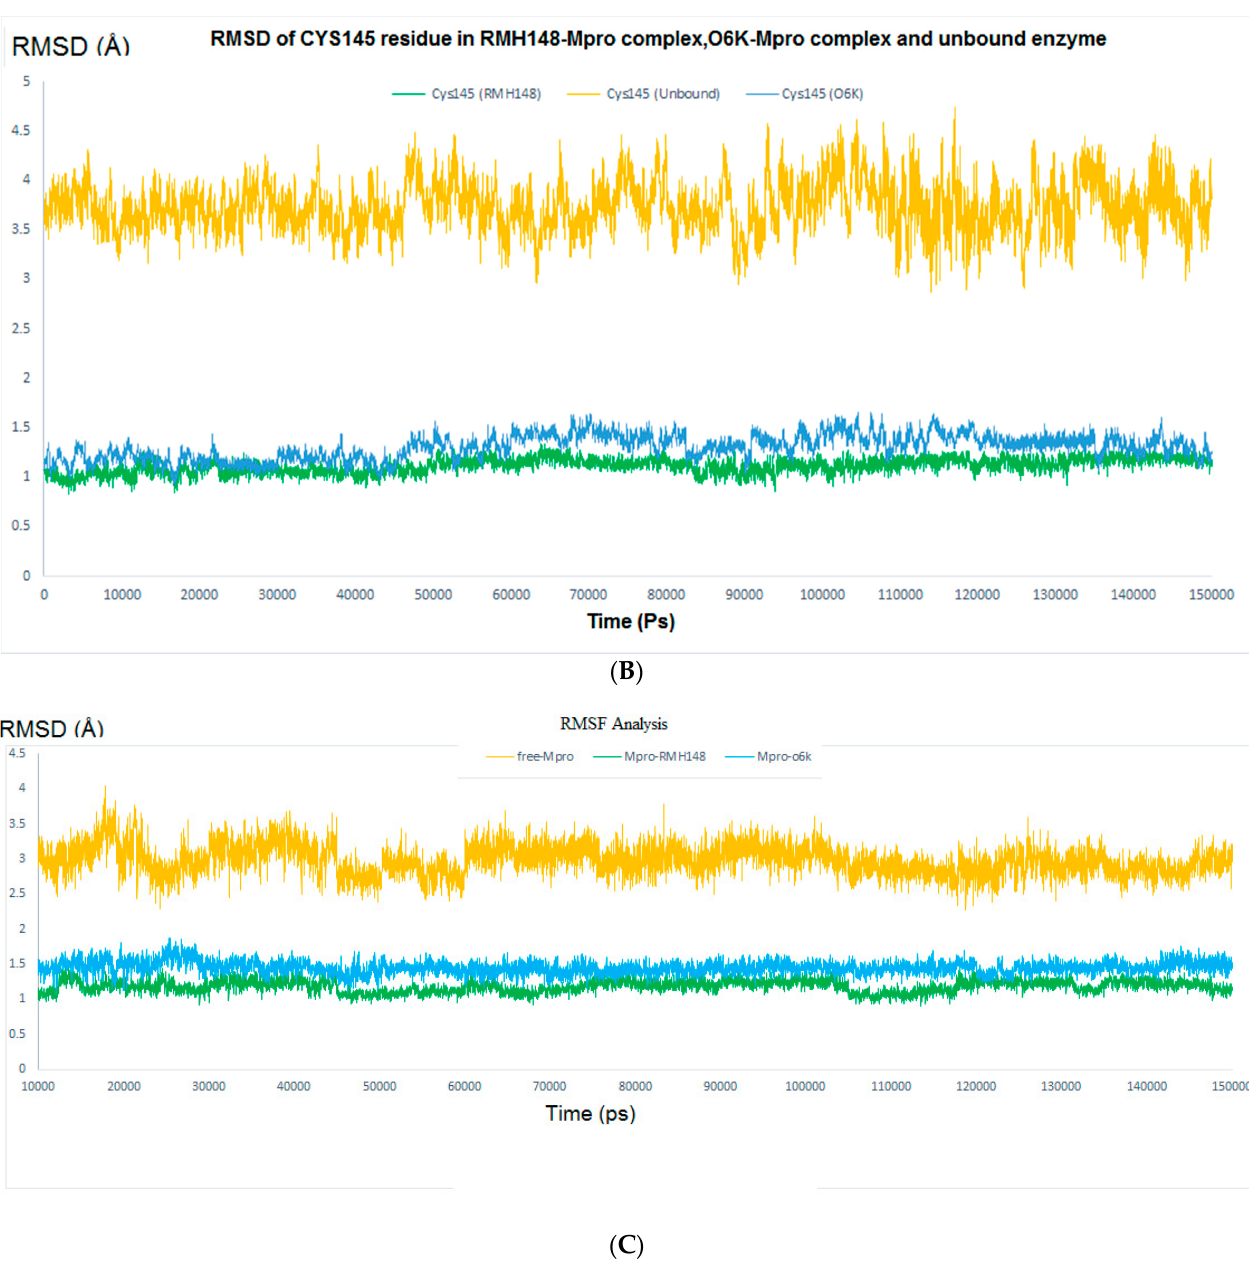
Figure 5. The RMSD analysis. ( A ) RMSD for the entire system. Orange color represents Mpro without a ligand, green color represents RMH148–Mpro complex and blue color represents O6K–Mpro complex. ( B ) RMSD for CYS145, orange color for Mpro without a ligand, green color for RMH148–Mpro complex and blue color for O6K–Mpro complex. ( C ) RMSF Analysis.